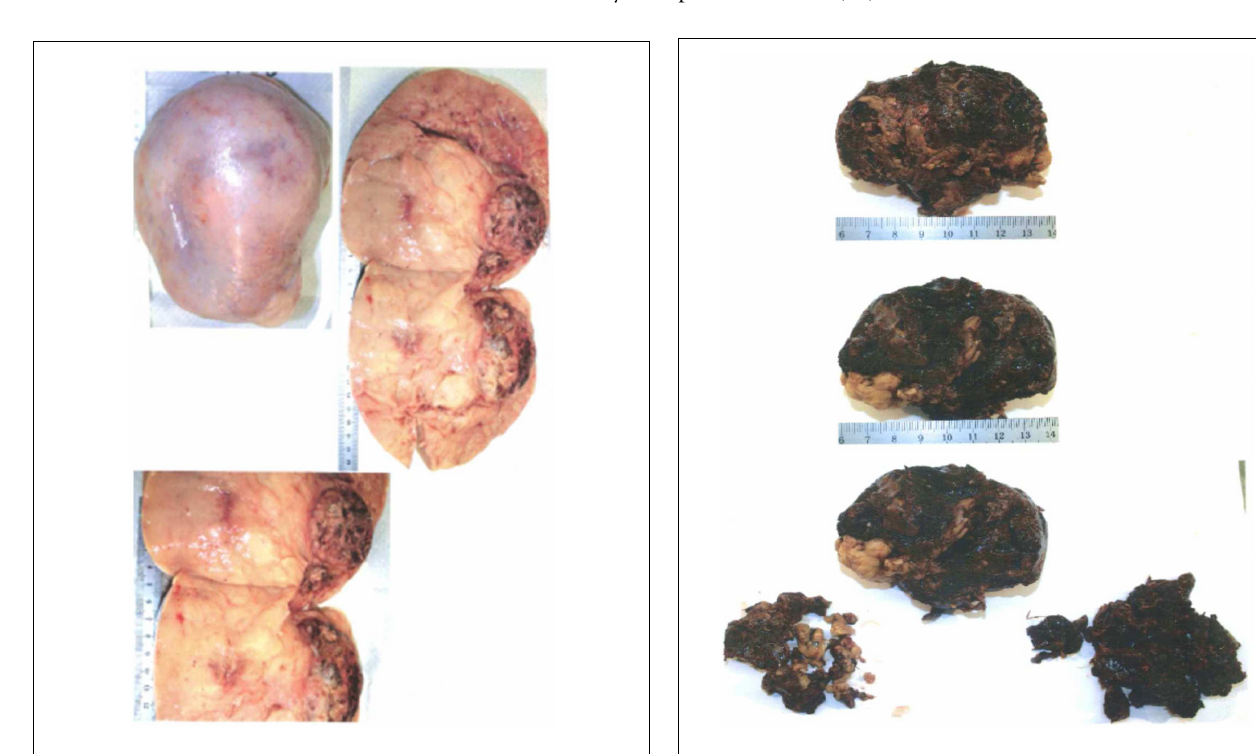
FIGURE 1 | Macroscopic view of germ cell tumor . FIGURE 2 | Macroscopic view of granulosa tumor